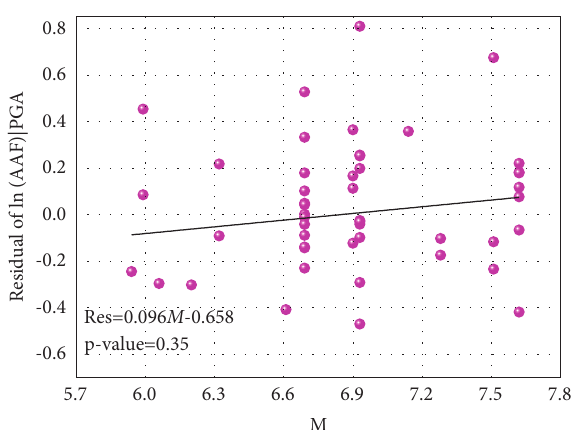
Figure 7: Testing the sufficiency of PGA with respect to M for predicting AAF.